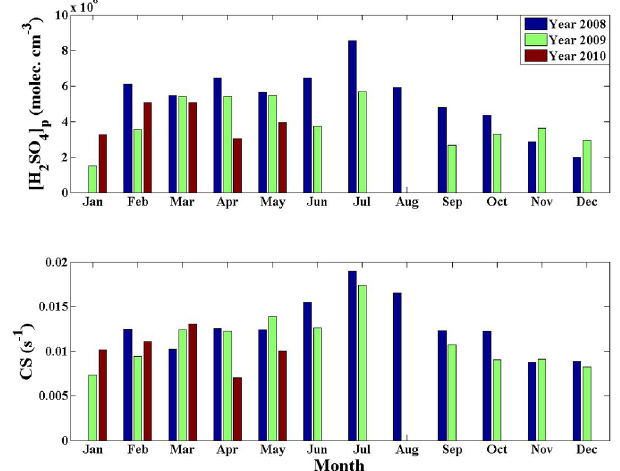
Fig. 7. Annual cycle of monthly medians of [H 2 SO 4 ] p and condensation sink. The figure includes observations made dur- ing February–December 2008, January–July 2009, September– December 2009, and January–May